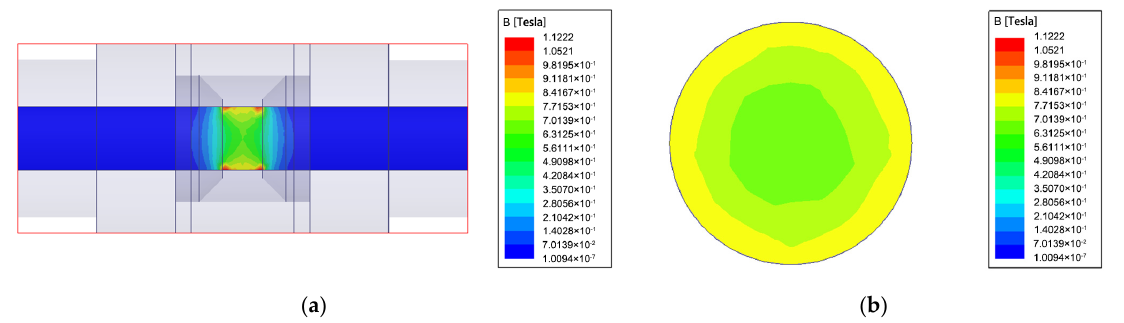
Figure 2. Static axisymmetric high-gradient static magnetic field analysis: ( a ) magnetic flux density in the axial direction and ( b ) magnetic flux density in the radial direction.